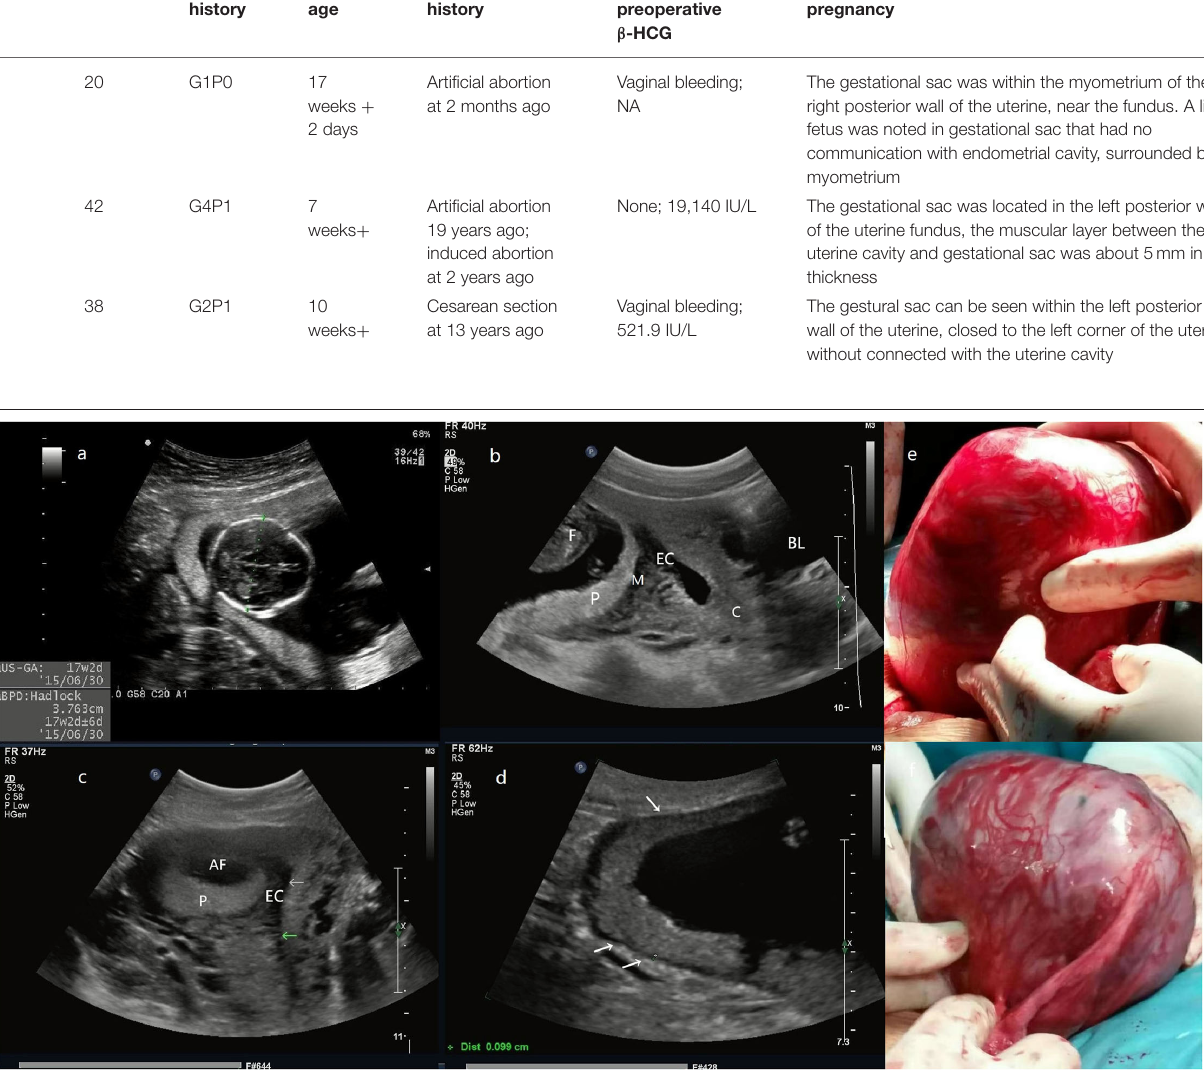
TABLE 1 | Demographic data and clinical characteristics of patients with intramural ectopic pregnancy in our hospital. Patients